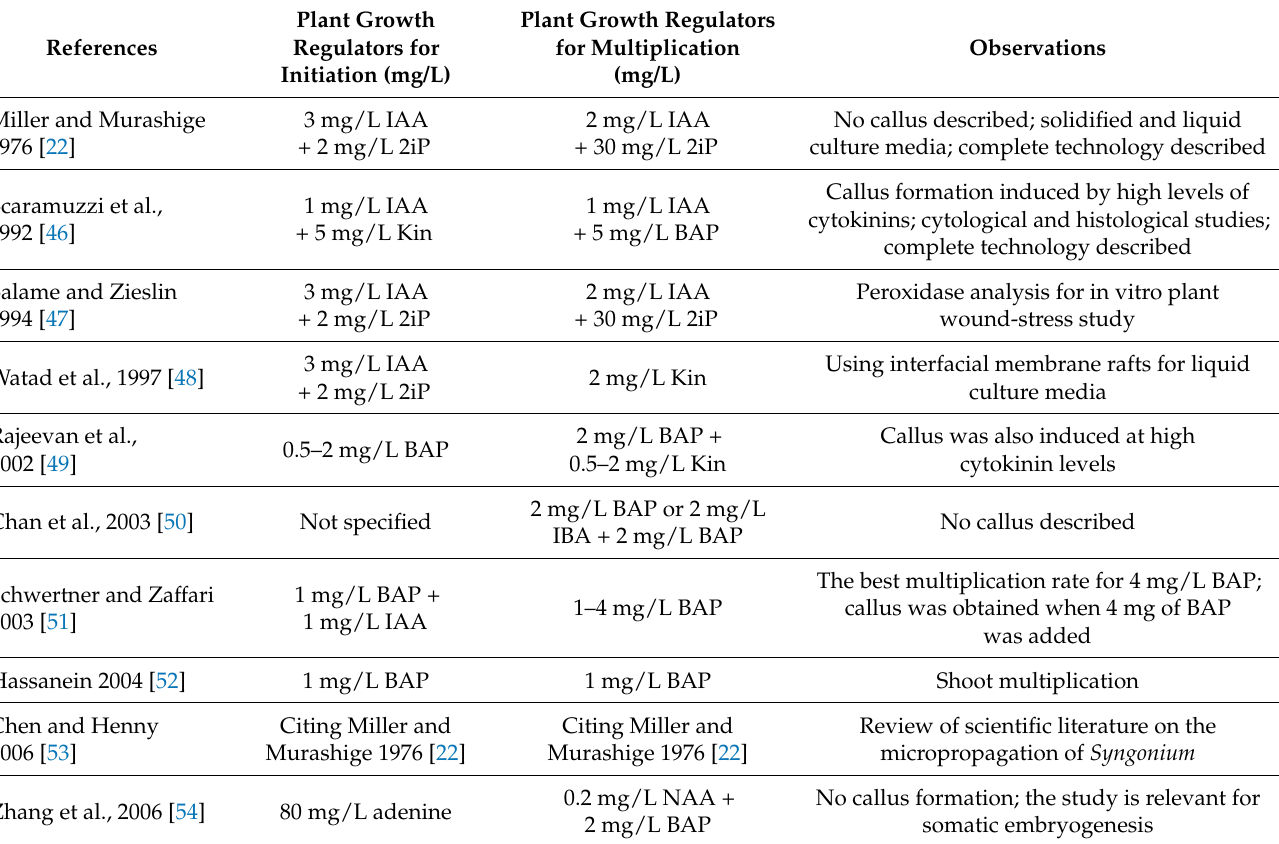
Table 1. Balance of plant growth regulators and relevant observations related to in vitro micropropa- gation of S. podophyllum from our review of scientific articles whose full text was freely available on Google